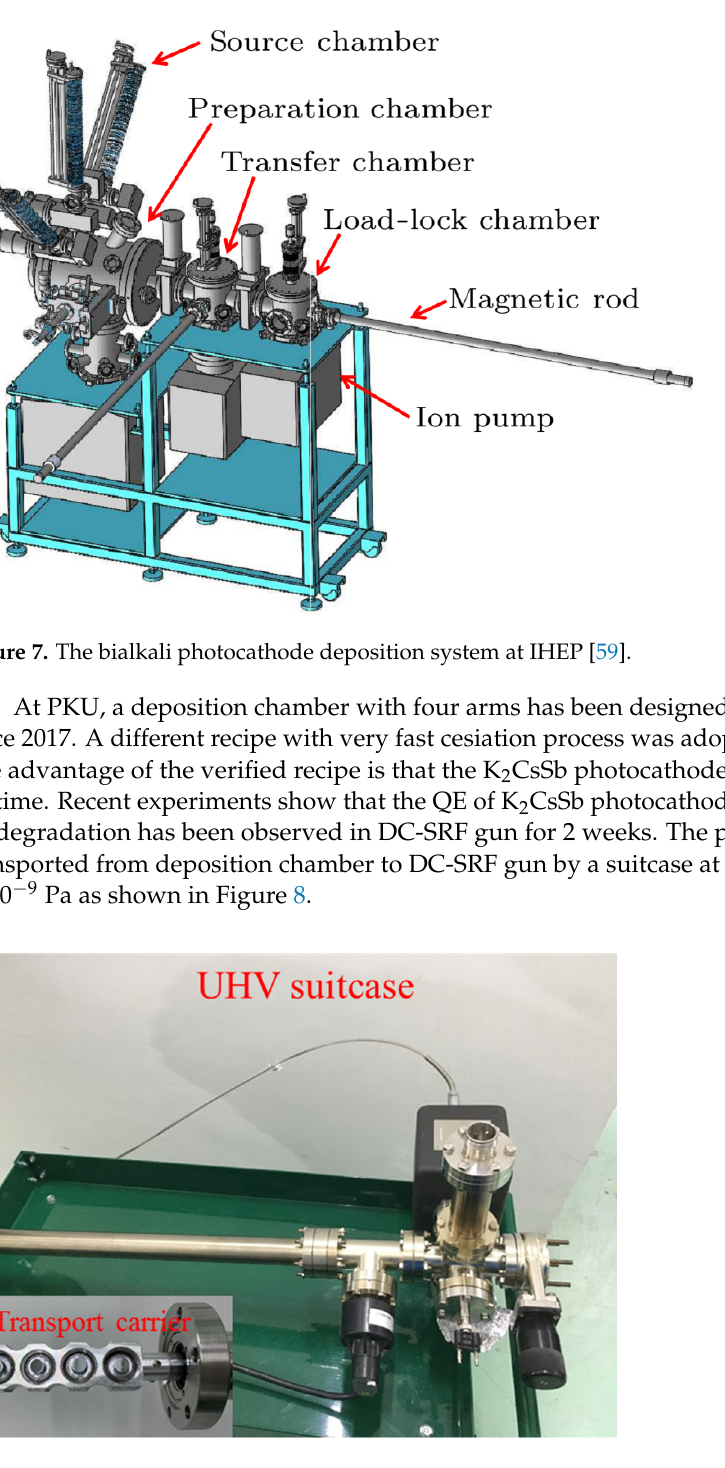
Figure 8. The UHV suitcase and transport carrier at PKU.